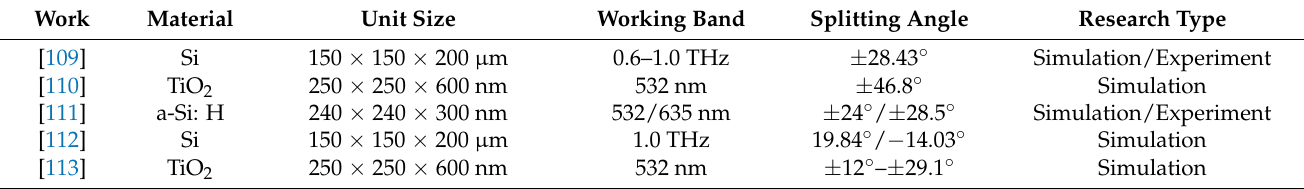
Figure 10. ( a ) Unit cell design [110]. ( b ) The incident light power is divided into three directions by angle [110]. ( c ) Polarization dependence of the power ratio [110]. ( d ) SEM image of the fabricated metasurface in top view [111]. ( e ) When the working wavelength is 532 nm ( i ) and 635 nm ( ii ), the distribution of light intensity on the image plane is measured. [111]. Table 4. Parameters of polarization-insensitive metasurface beam splitters described in this